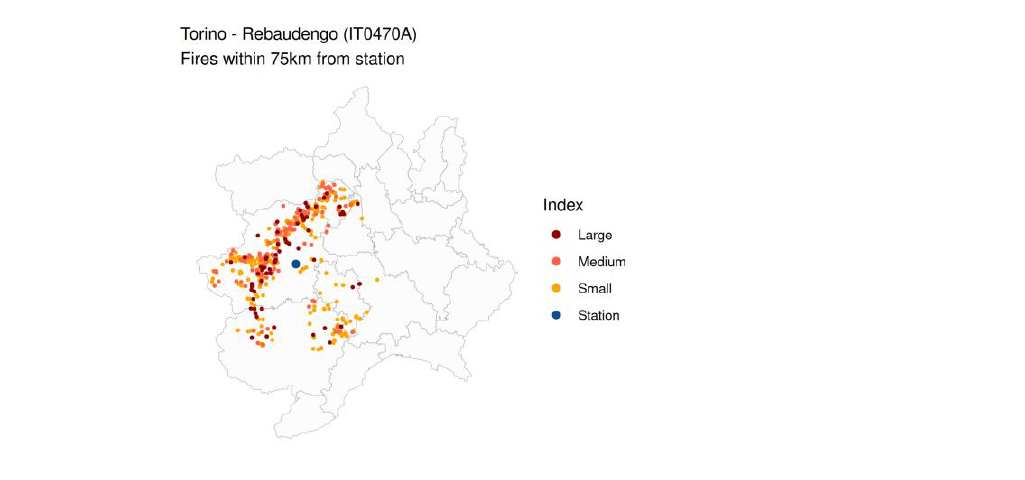
Table 6. Val di Susa wildfire event in IT0470A station: comparison between estimated wildfire PM 10 contribution from model and wildfire contribution from speciation, in relation to PM 10 measured concentrations.